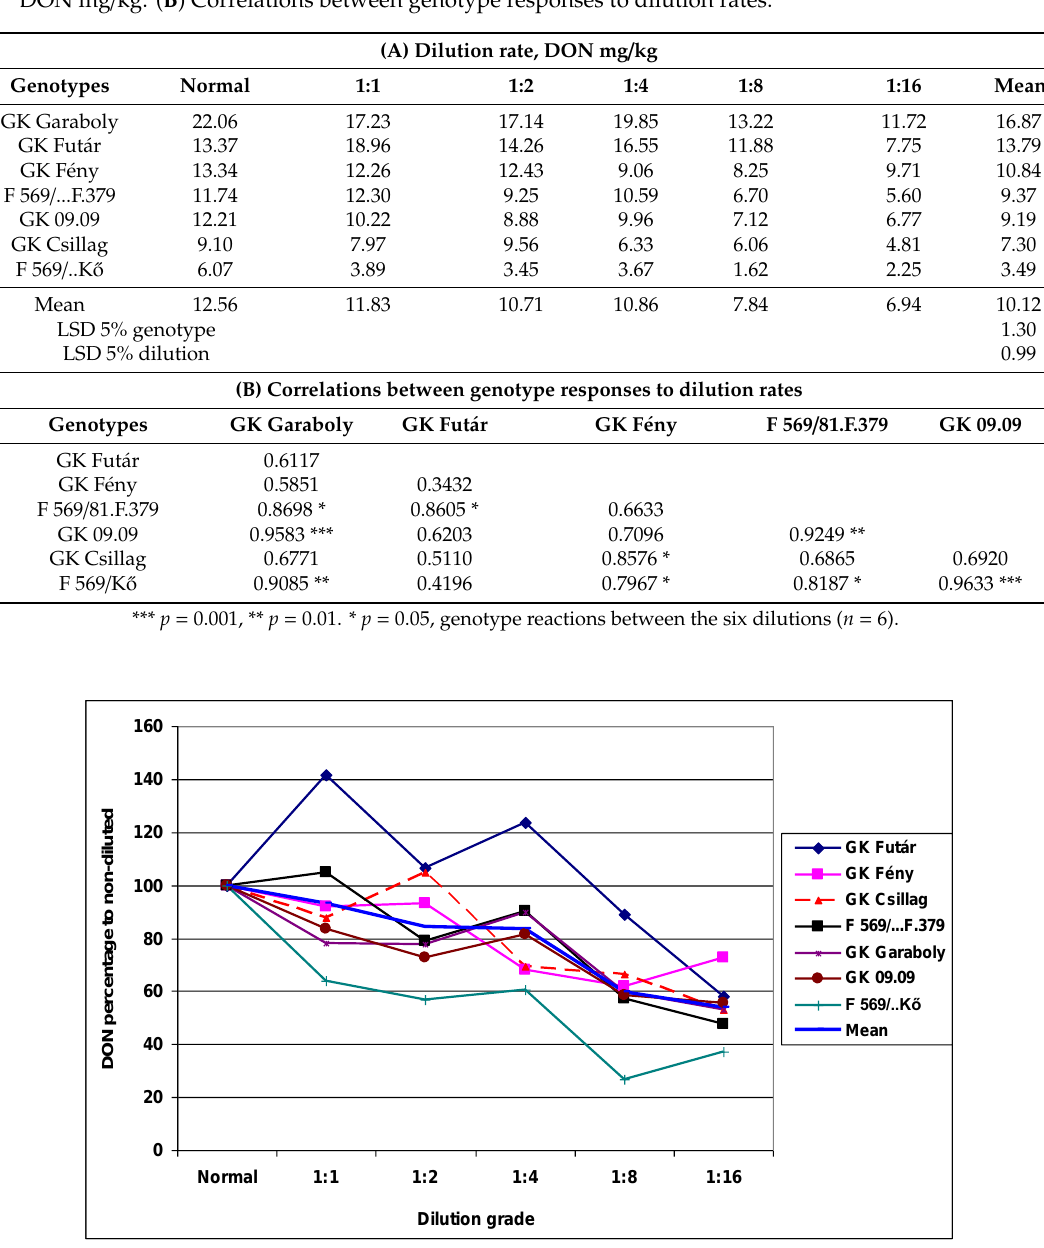
Figure 7. Reduction of the DON contamination at genotypes with di ff ering resistance and at di ff erent dilution rates, relative DON data as % to the non-diluted control inoculum, 2013 and